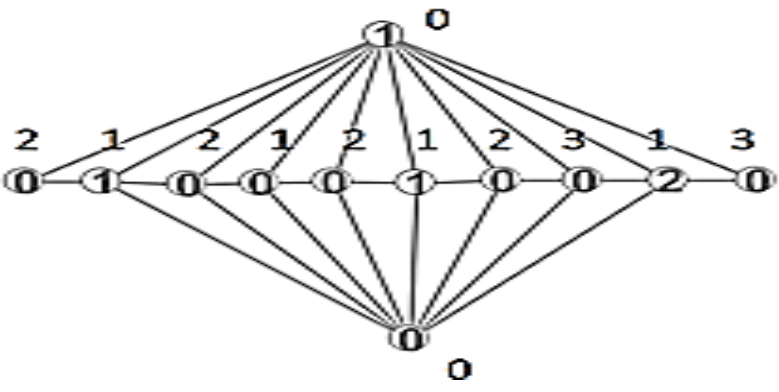
Figure 2. Switching with modular coloring in Ws(11)